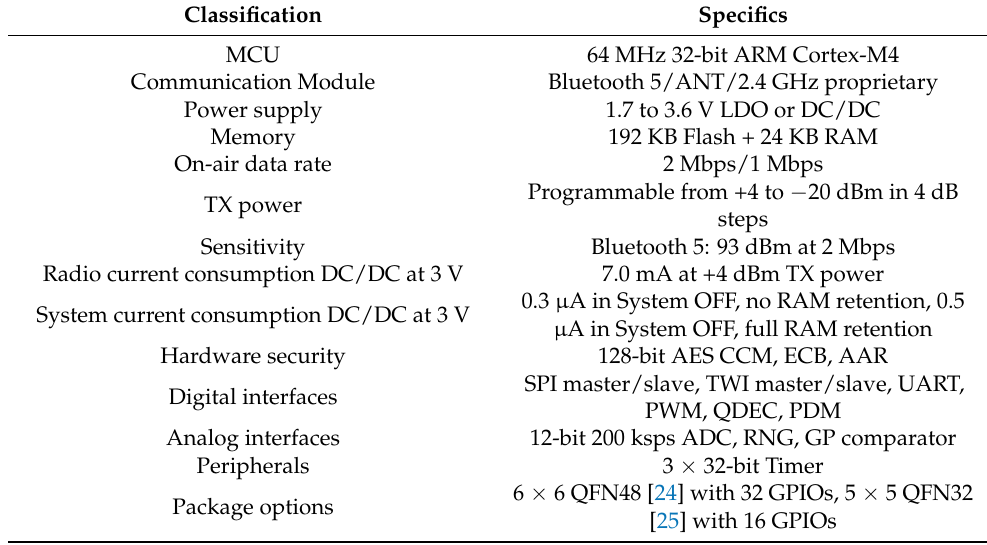
Table 1. Core specifications of MCU, communication module, power supply, etc.